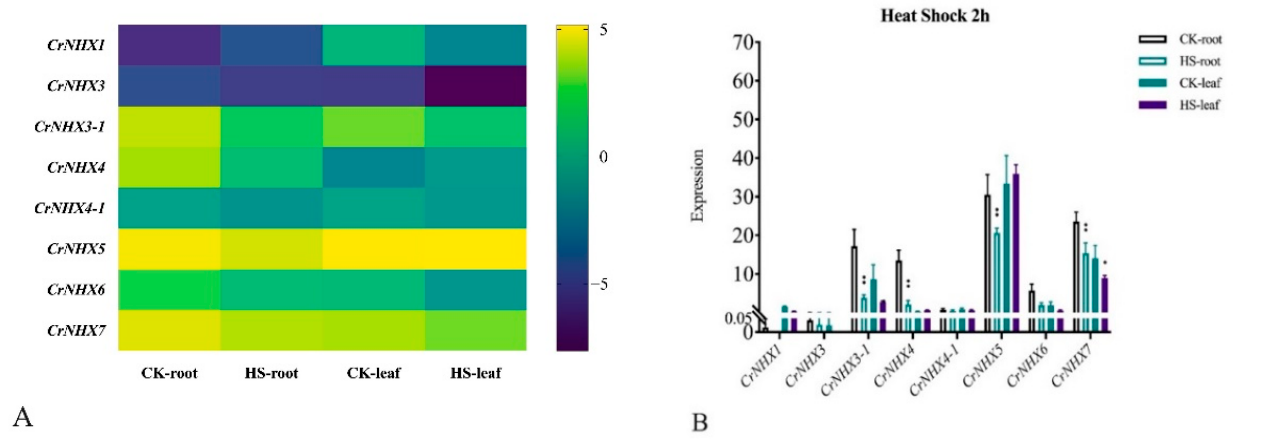
Figure 8. ( A ) Heatmaps showing the expression levels of the eight CrNHX s under heat shock stress. The expression level of each gene is shown in FPKM (log2). Expression levels for each CrNHX were shown with the log2 values of FPKM. Yellow denotes high expression levels, and dark-blue denotes low expression levels. ( B ) The FPKM histogram of the RNA-seq data for the expression patterns of eight CrNHX s in the root and leaf samples captured from the heat-shock-treated C. rosea seedlings. The error bars indicate the ± SD based on three replicates. Asterisks indicate significant differences from the CK (control check, without heat stress, Student’s t -test, * p < 0.05 and ** p <